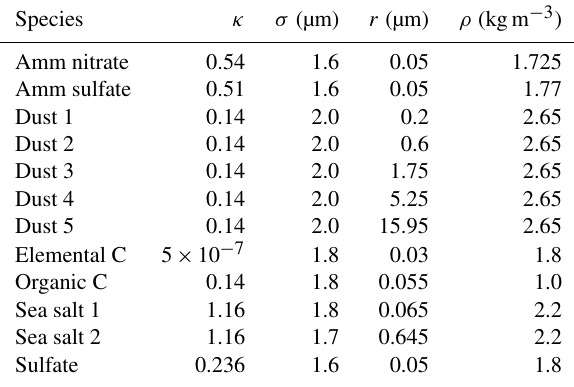
Table 1. Aerosol physical and chemical